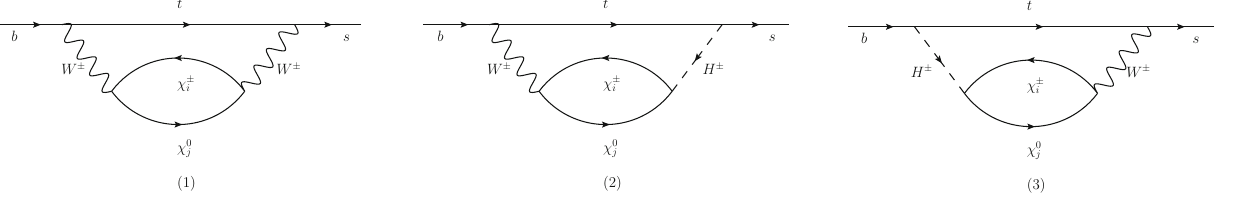
Fig. 2 The relating two loop diagrams in which a closed heavy fermion loop is attached to virtual W ± bosons or H ± , where a real photon or gluon is attached in all possible ways